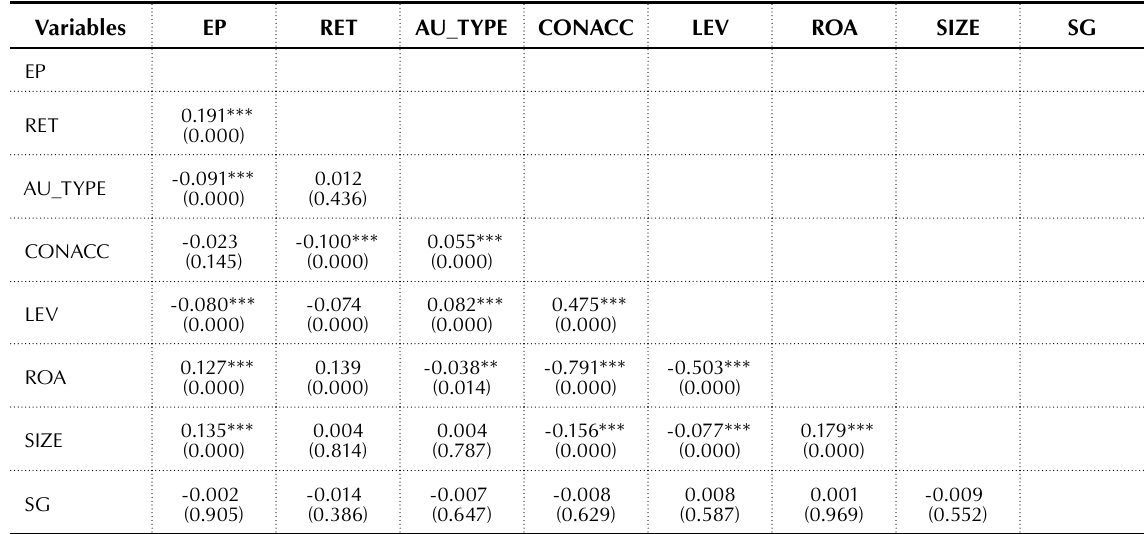
Table 3. Pearson